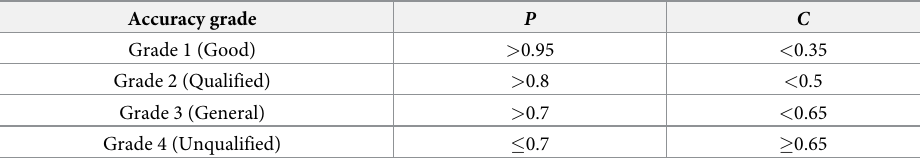
Table 4. Evaluation of model accuracy.